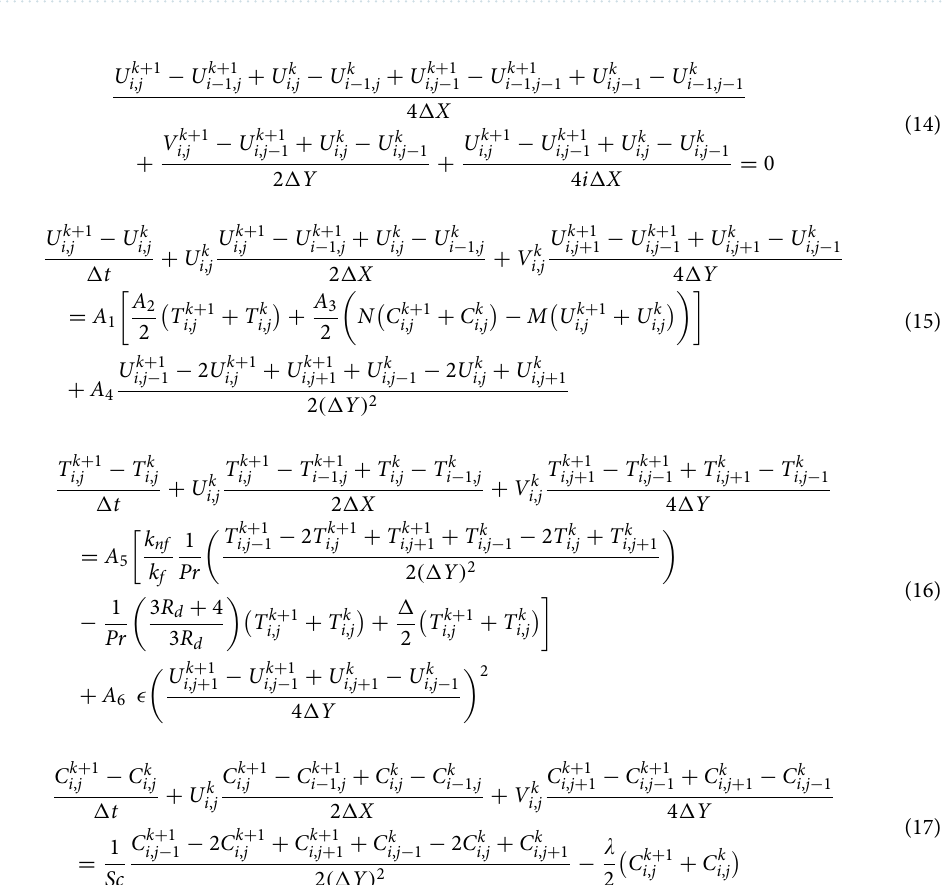
Table 1. Thermo-physical properties 19,46 of water and